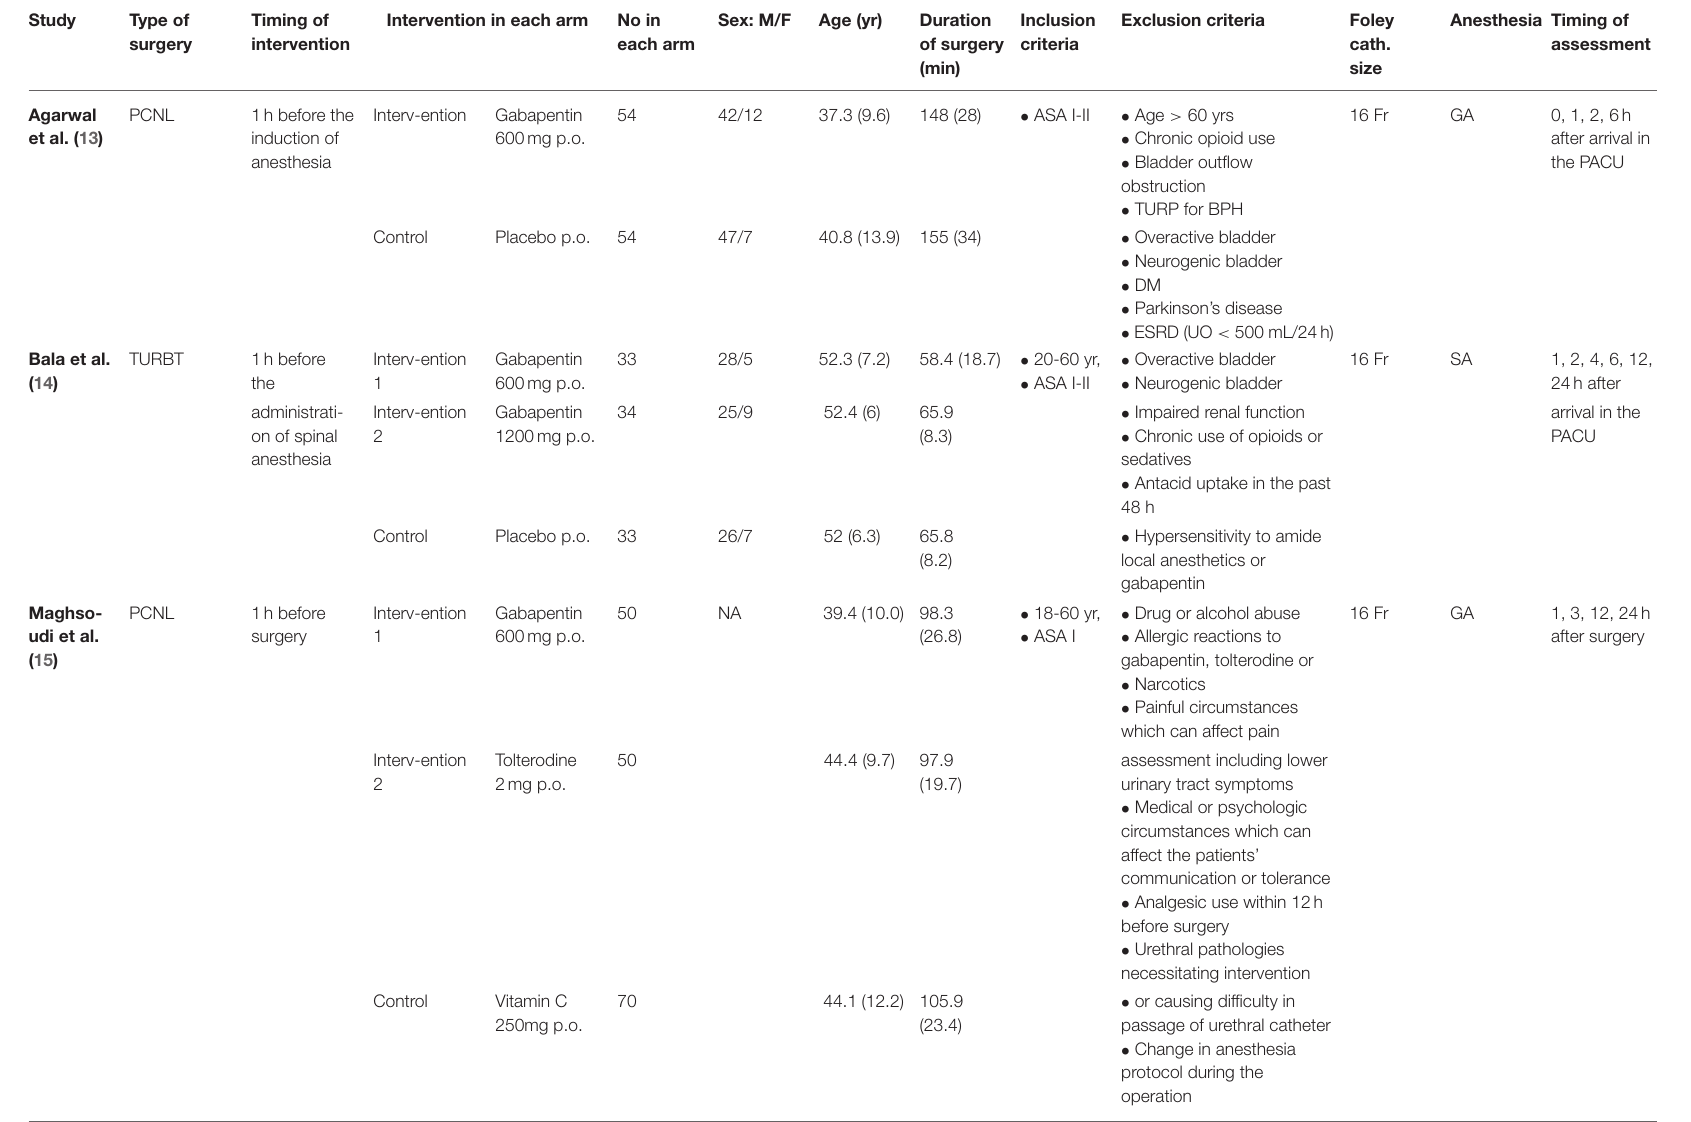
TABLE 1 | Characteristics of included